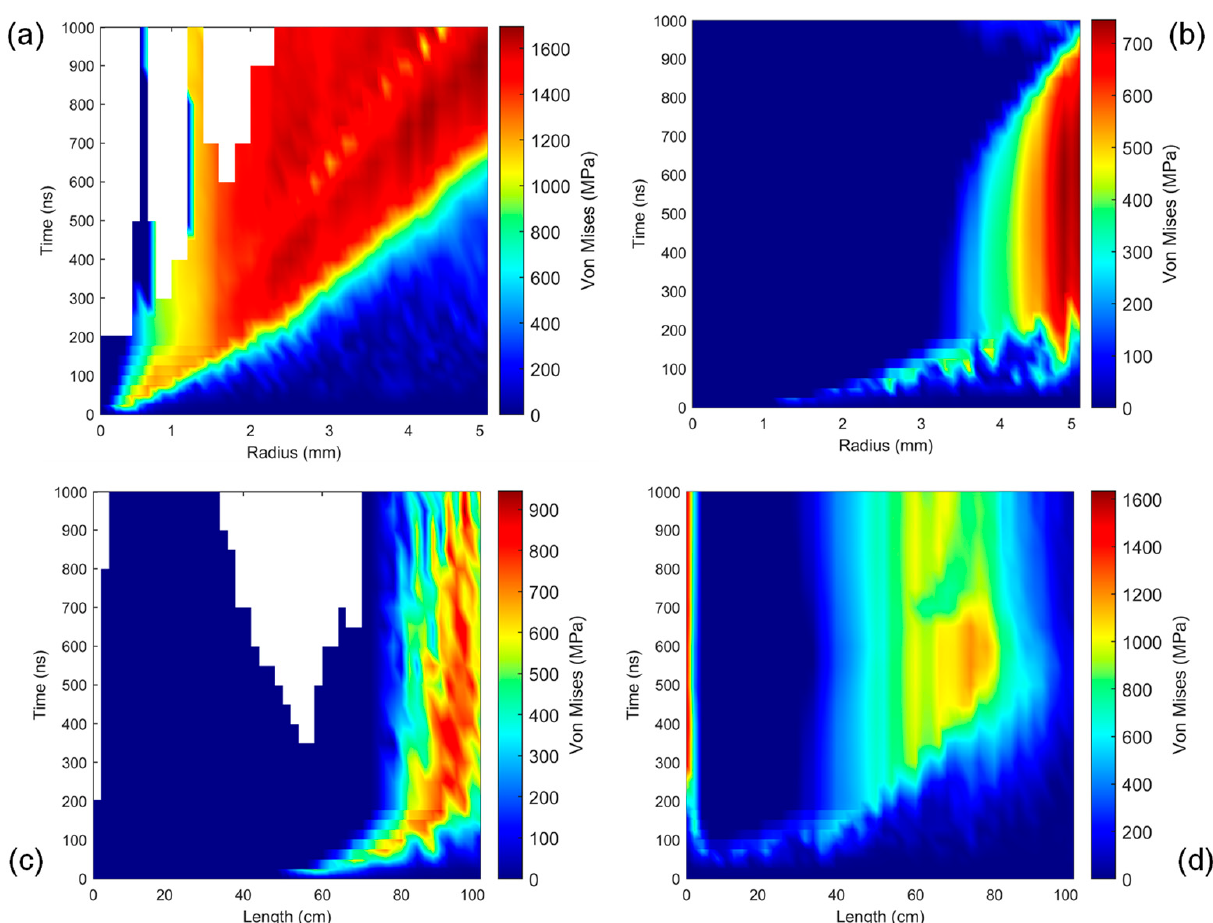
Figure 13. Von Mises stress distributions at ( a ) L 0 , ( b ) L Emax , ( c ) R 0 , and ( d ) R 2.5 (see Figure 5).